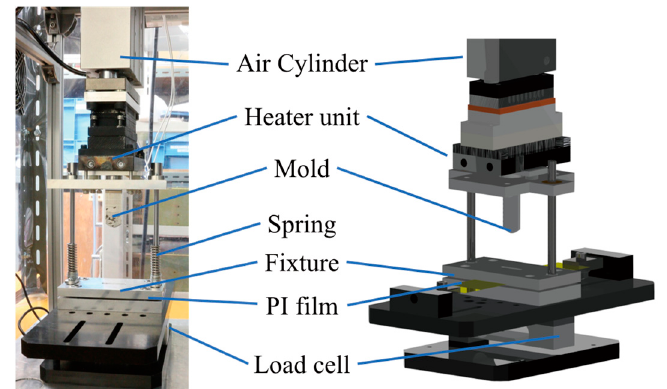
Figure 9. Molding machine for PI film.